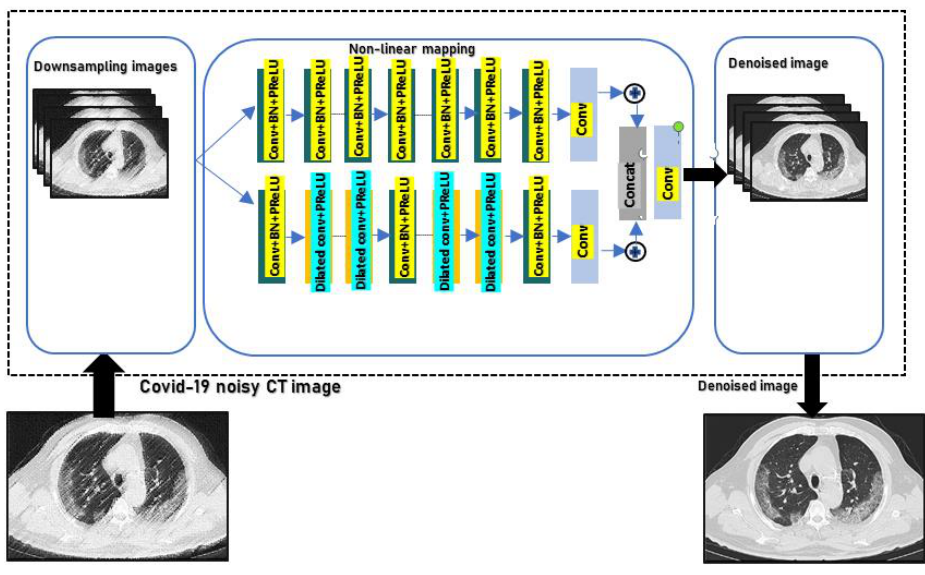
Figure 1. Proposed CNN denoising framework.